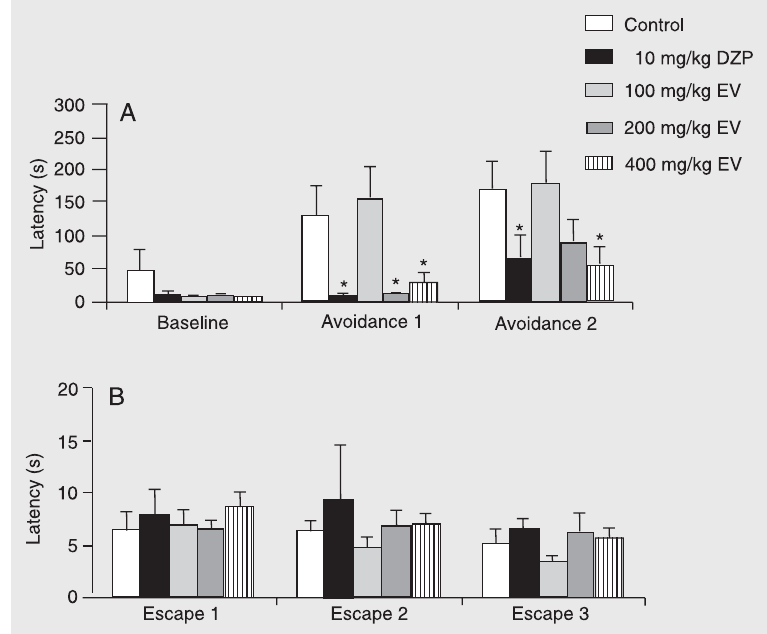
Figure 1. Effect of acute oral administration of a water-alcohol extract of Erythrina velutina (EV) and of diazepam (DZP) on the behavior of rats submitted to the avoidance (panel A) and escape (panel B) tasks of the elevated T-maze. Data are reported as means ± SEM. N = 12 for all treatment groups. *P < 0.05 compared to control (Duncan test).